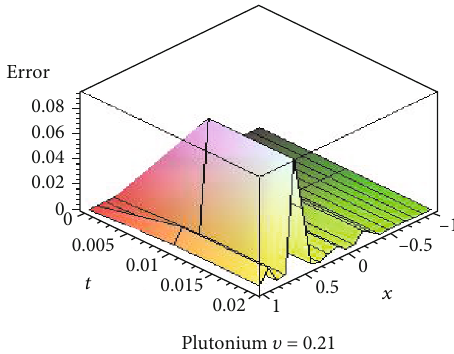
Figure 11: The value absolute error by PNM at N = 10 and T = 0 : 02 .